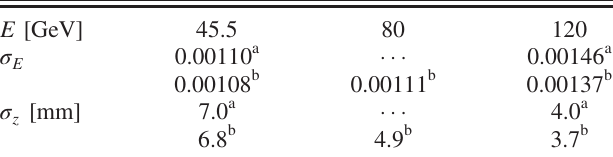
TABLE I. The bunch energy spread and length due to the SR þ BS effect at CEPC.